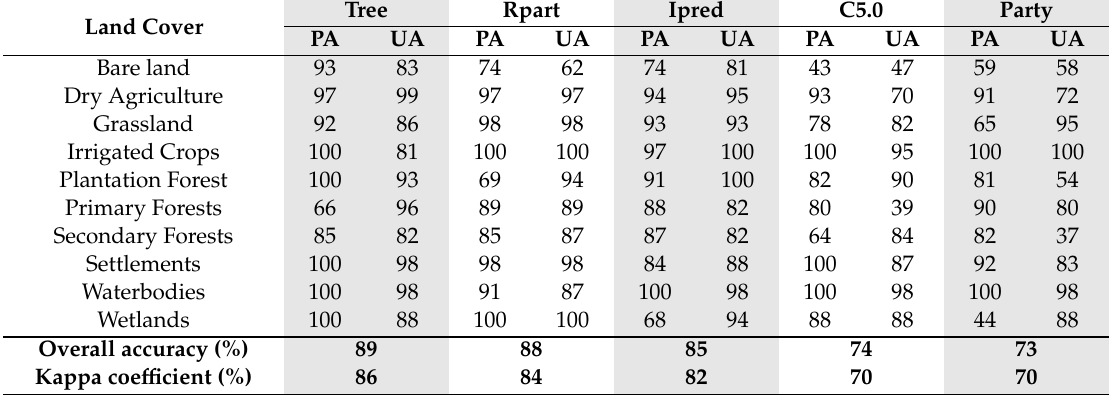
Table 5. Summary of accuracies for land cover classification using Tree, Rpart, Ipred, C5.0, and